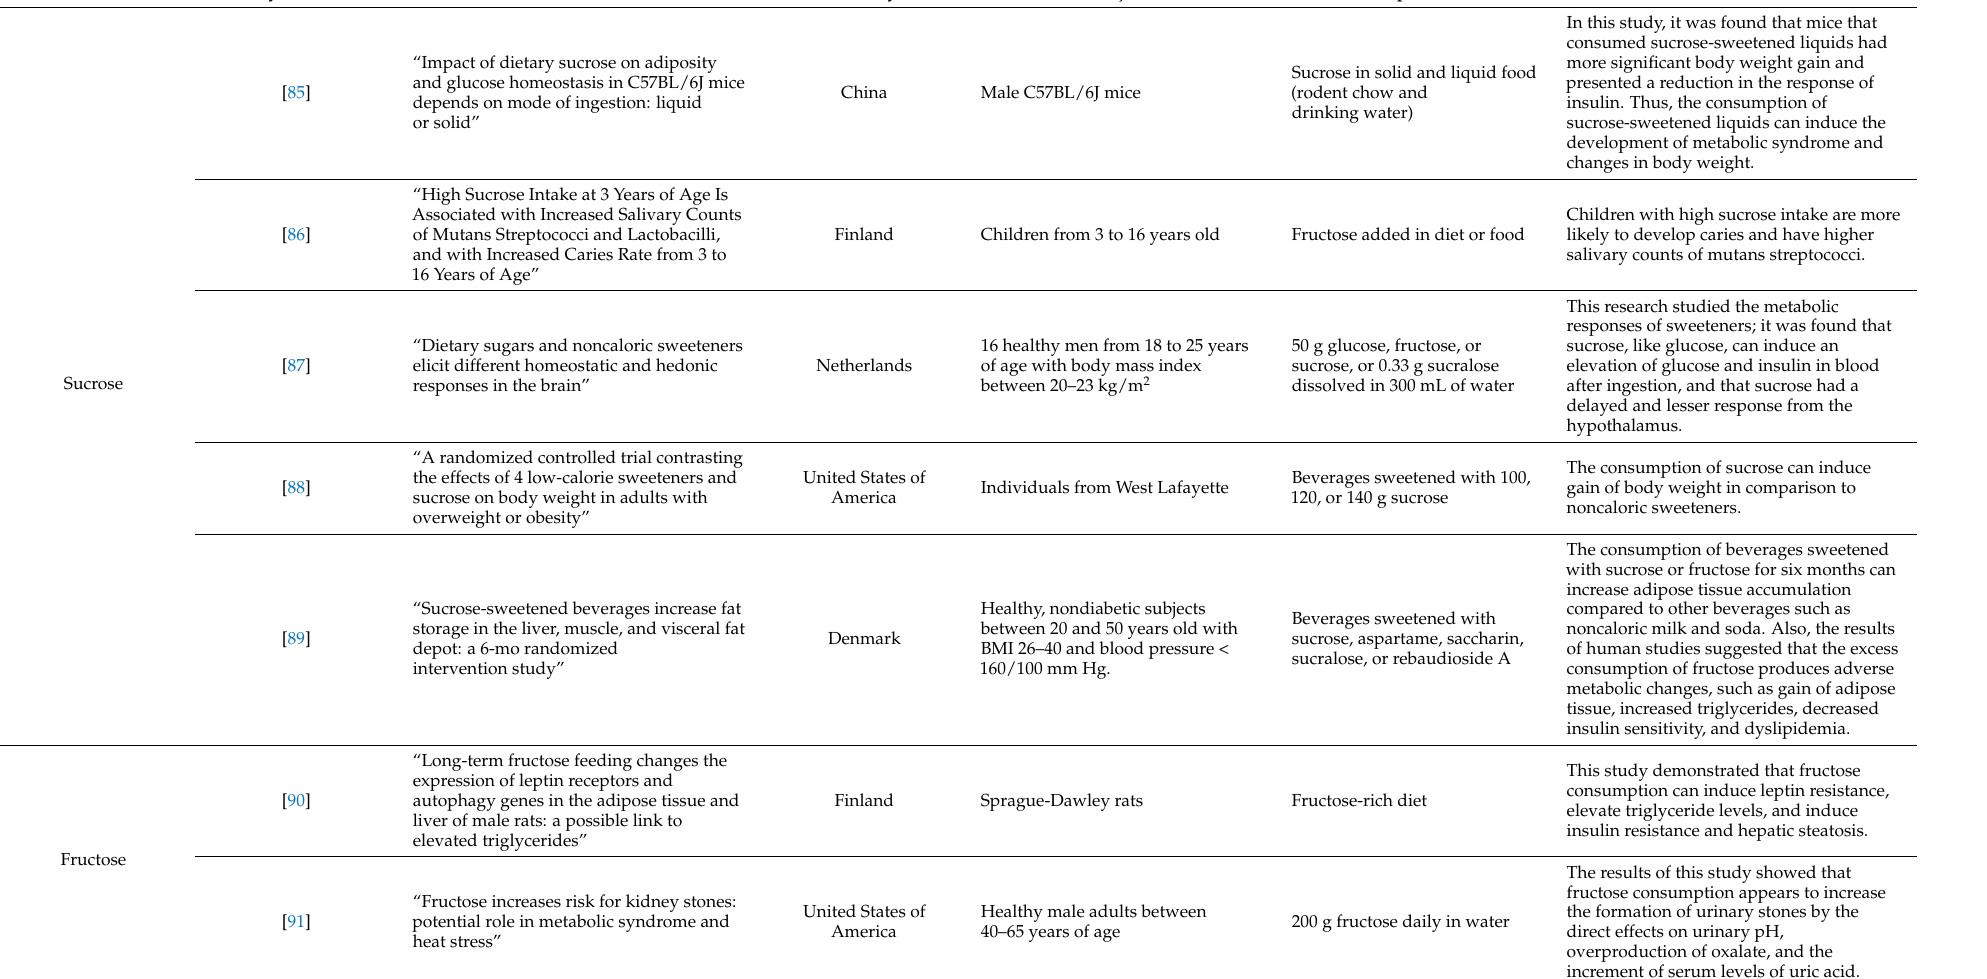
Table 4. Publications related to sweeteners and their health